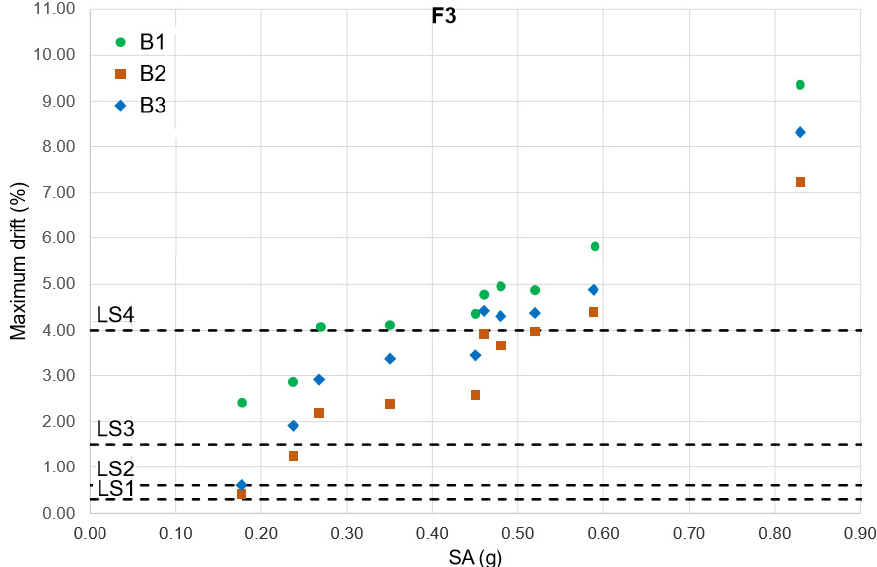
Figure 7. Results: model B1, B2, B3 considering soil F3.